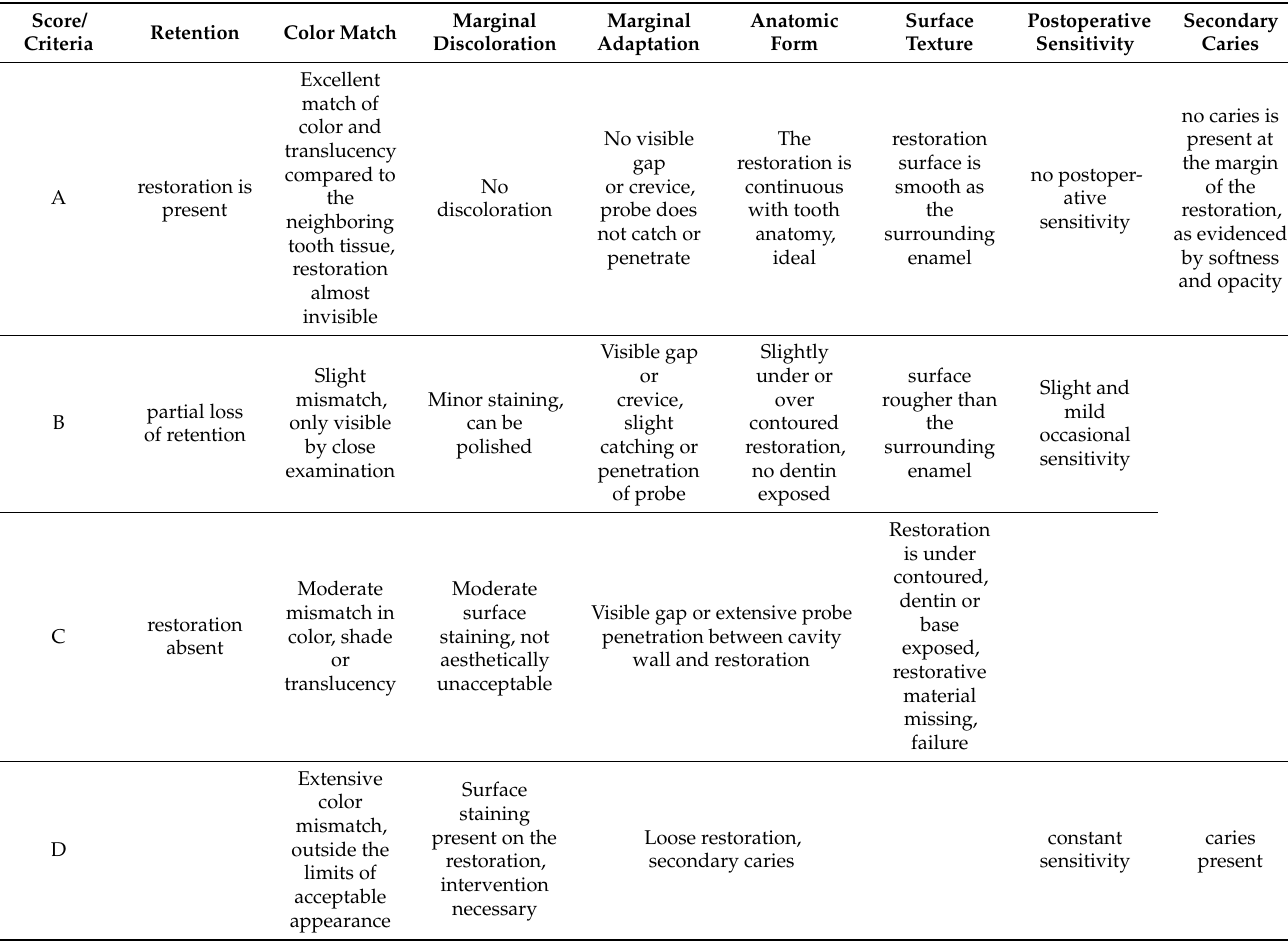
Table 2. Modified criteria from the United States Public Health Services. A: Alpha score. B: Bravo score. C: Charlie score. D: Delta